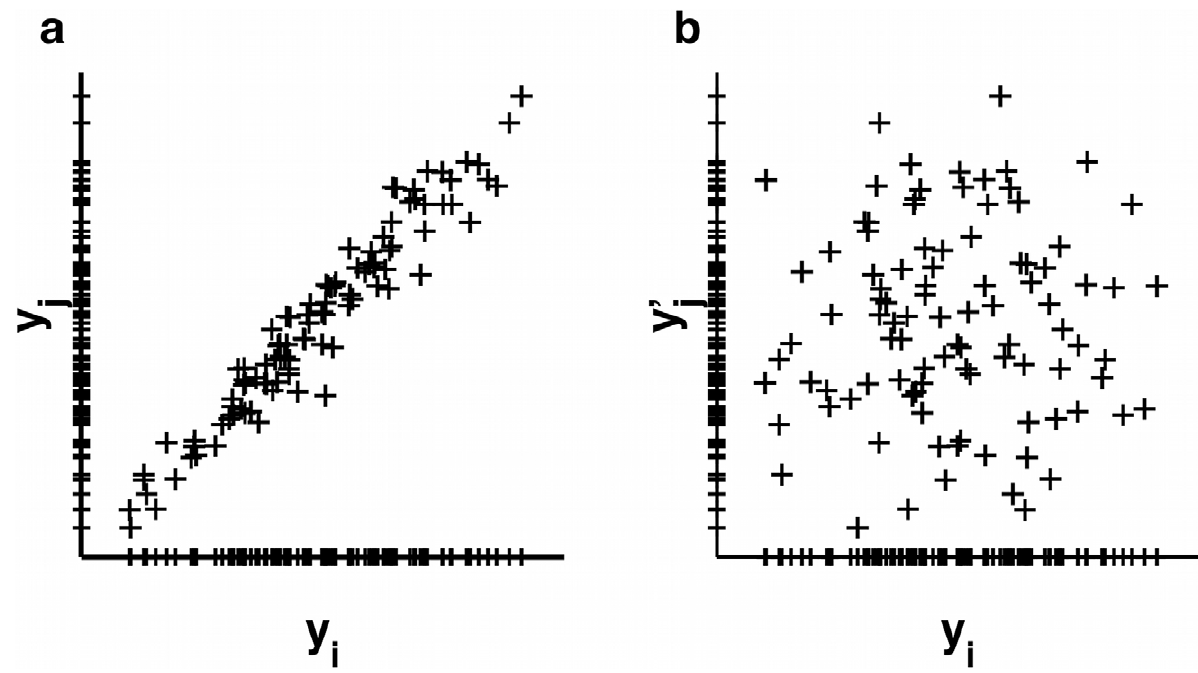
Figure 3. Principle of fill modes. a) Two arbitrarily correlated modes y i and y j marginally distributed on the axes. Correlation is clearly visible from the y j -distributed y i . The joint distribution r ( y i , y j ) is more sparsely sampled than both marginal distributions. b) The y j 0 -distributed y i is decorrelated and has exactly as many sample points as the joint distribution in a), allowing precise computation of I 2 ( y i , y j )